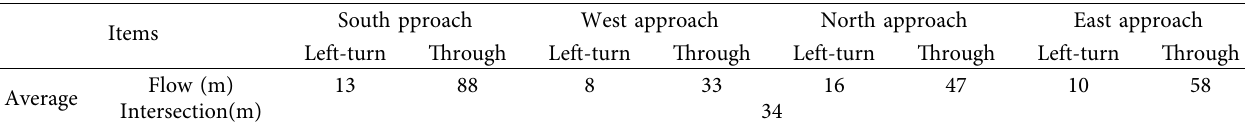
Table 4: Simulation queue length of the current intersection signal control scheme.